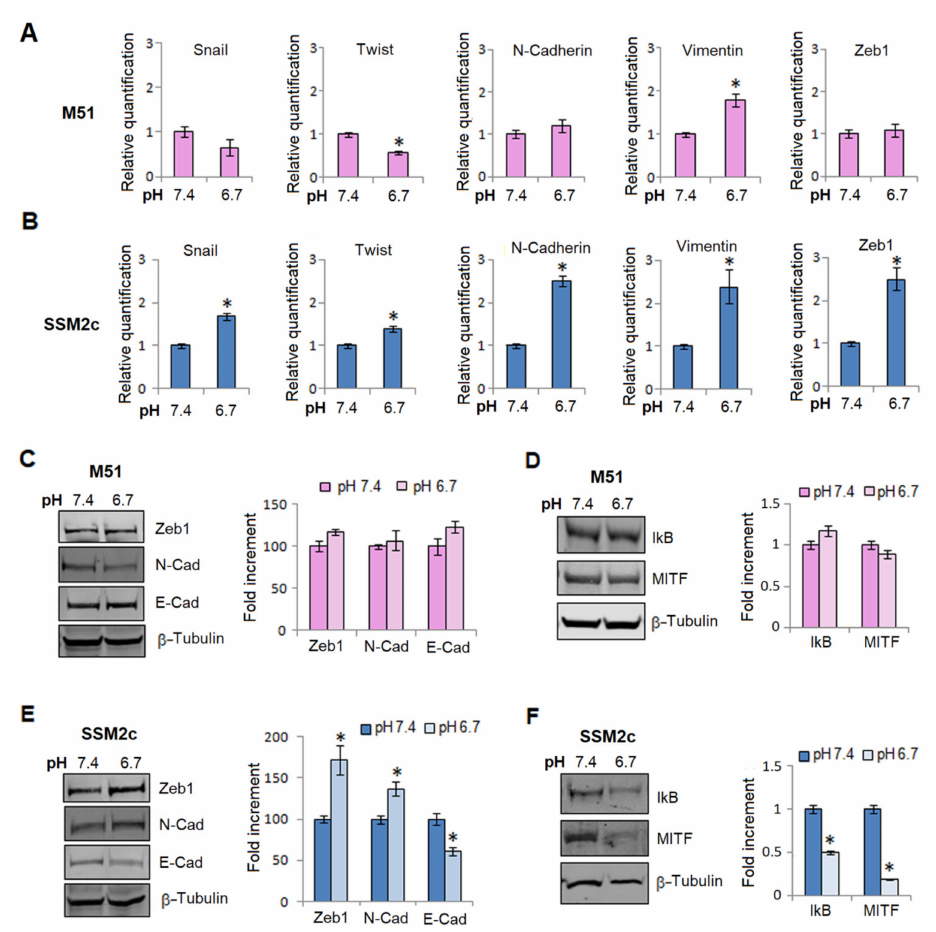
Figure 2. EMT reprogramming in acidic male and female melanoma cells. mRNA level of EMT markers of M51 female melanoma cells ( A ) and SSM2c male melanoma cells ( B ) grown in an acidic medium for 24 h. Zeb1, E-cadherin, N-cadherin protein expression ( C ), and IKB and MITF protein expression ( D ) performed by Western blotting of female M51 melanoma cells. Zeb1, E-cadherin, N-cadherin protein expression ( E ), and IKB and MITF protein expression ( F ) performed by Western blotting of male SSM2c melanoma cells. Each band of the western blot was quantified by densitometric analysis, and the corresponding histogram was constructed relative to β -tubulin. Representative Western blot panels on the left. Histograms represent the mean ± SEM of at least three independent experiments. * p < 0.05 compared with control